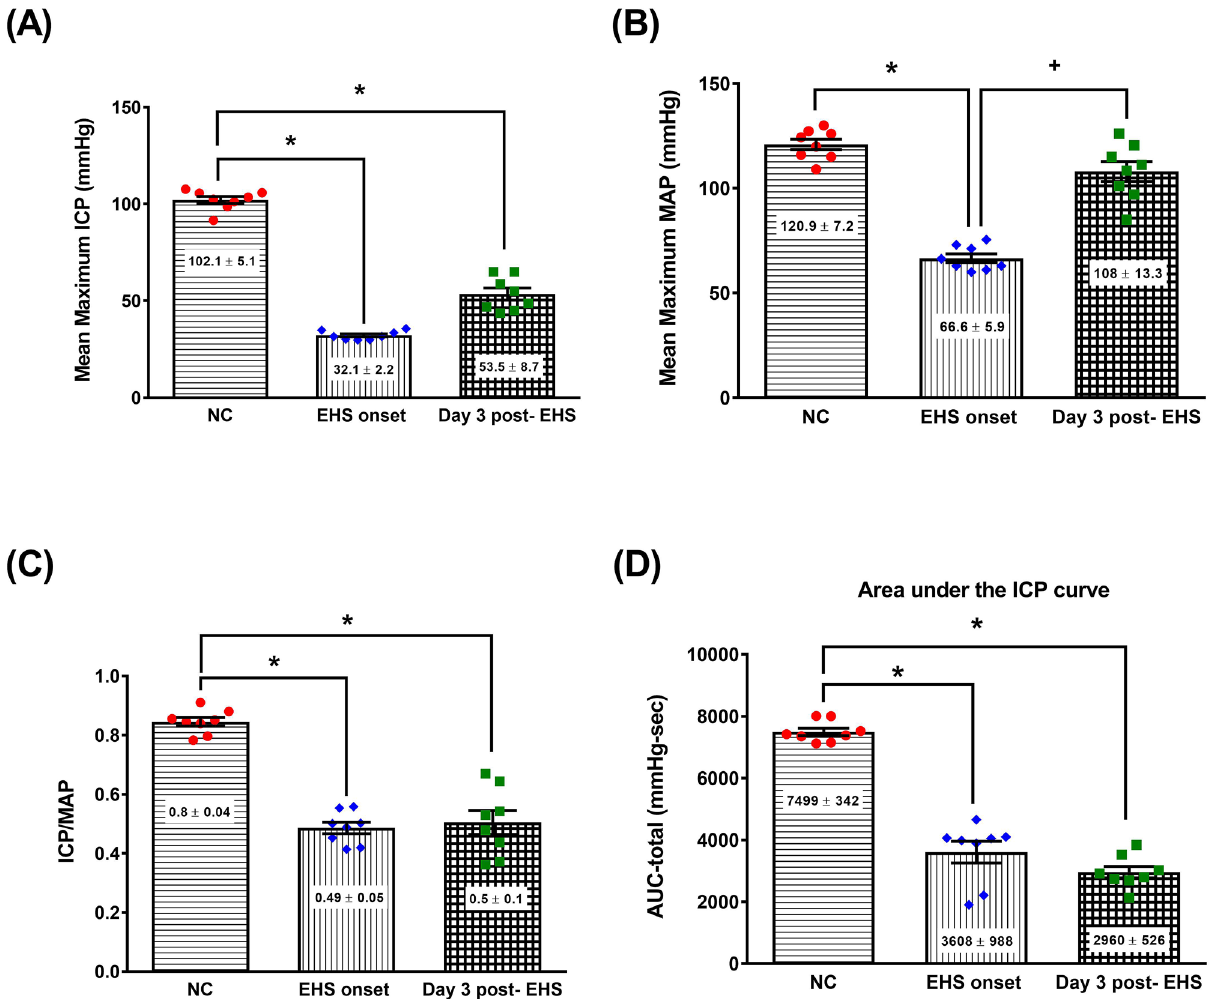
Figure 6. The values of ( A ) mean maximum intracavernosal pressure (ICP), ( B ) mean maximum arterial pressure (MAP), ( C ) ICP/MAP, and ( D ) area under the ICP curve (Auc-total) of rats in different groups. Data are presented as the mean ± standard deviation (n = 8 per group). *P < 0.05, EHS onset vs. NC, or Day 3 post- EHS vs. NC. + P < 0.05, Day 3 post-EHS vs. EHS